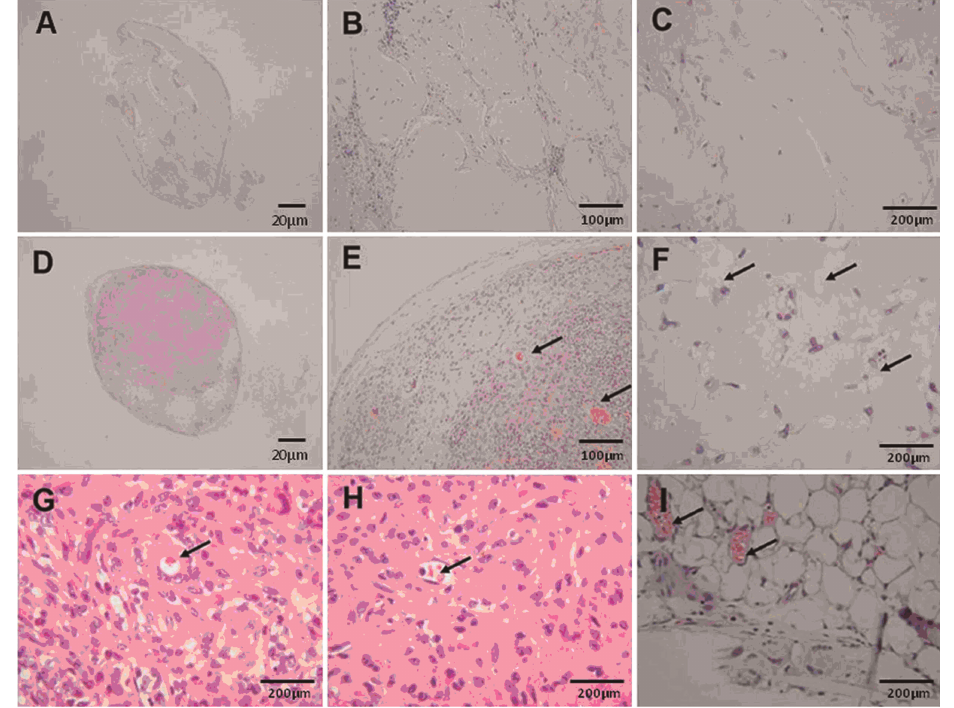
Figure 5. Successful regeneration of the quasi-natural cell block in vivo . H&E staining showed small numbers of the transplanted ADMS cells in the conventional mixture approach as well as a general unhealthy shape of the transplanted cells ( A-C ). In contrast, the quasi-natural cell block implants displayed successful proliferation of implanted ADMS cells ( D, E ). Morphological examinations further revealed differentiation of ADMS cells into various cell types as well as formation of capillary vessels with erythrocytes ( E-I ). Arrows indicate erythrocytes (E, G), adipocytes ( F ), or multinuclear giant cells ( H, I